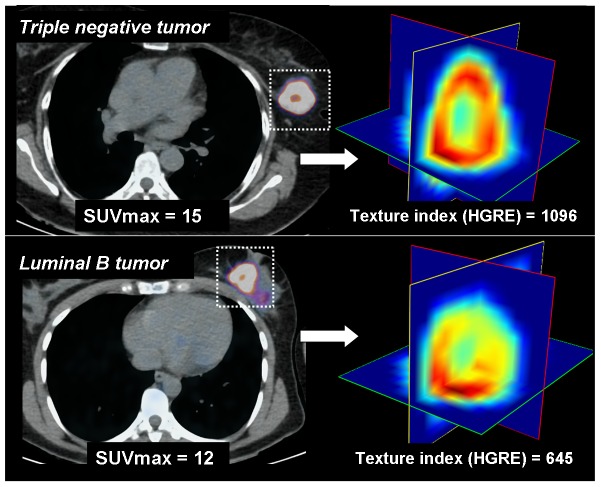
Illustration of tumor heterogeneity at FDG-PET/CT in the different subtypes of breast.Axial PET fusion images (left) and 3D-view of 3 orthogonal plans from the tumor volume (right) after voxel resampling are displayed. Two histologic types of breast tumor are displayed: triple negative (top) and luminal B (bottom) tumors. Both tumors exhibit intense FDG uptake with a central hypometabolic area. The triple negative breast tumor exhibits higher SUVmax and higher textural heterogeneity than the luminal B tumor (right). This example illustrates higher FDG uptake and higher texture heterogeneity in TNBC compared to non-TNBC.